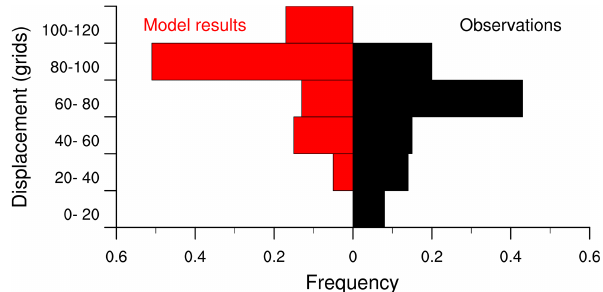
Figure 2. Histograms for the distribution of displacement distances computed from Eq. (5) for the ice edges displayed in Fig. 1. The mean displacement distances for model results and observations are 82 grids and 61 grids, respectively. The corresponding median val- ues are 88 grids and 70 grids, respectively.